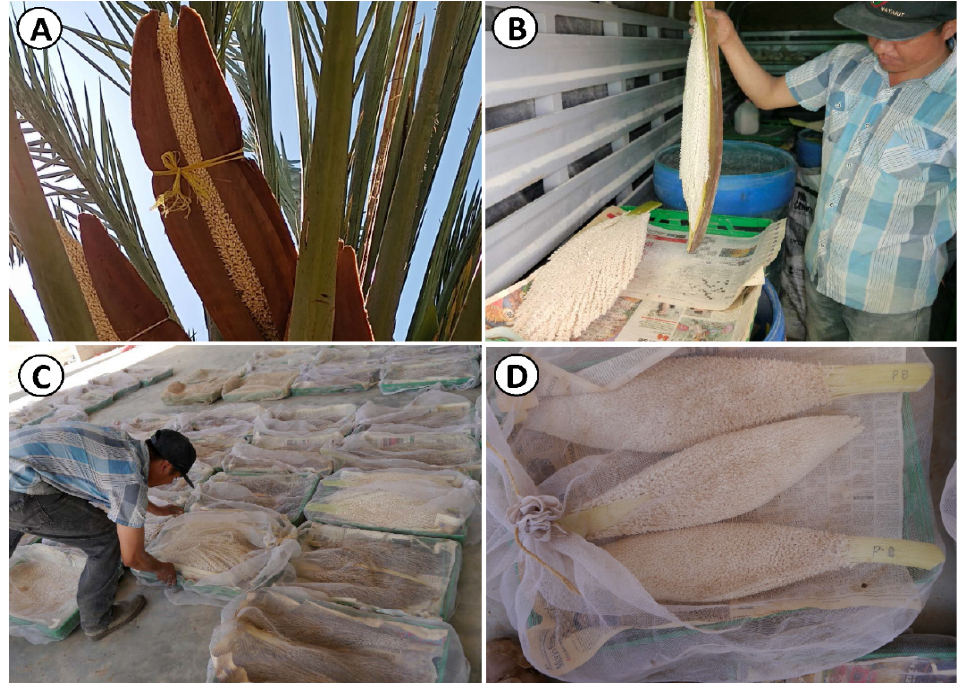
Figure 2. Drying of male date palm inflorescences for pollen extraction. ( A ) Inflorescence ready to be cut from the palm and tied to prevent pollen dispersal. ( B ) Manual opening of the inflorescences. ( C ) Drying area. ( D ) Group of three inflorescences covered with a fine mesh screen on a layer of paper, in the process of drying in the open air.